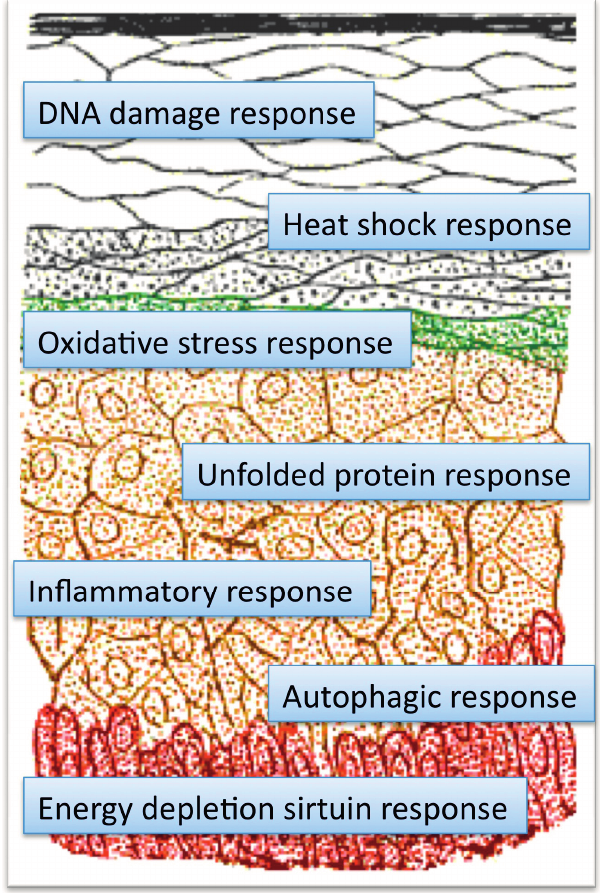
Figure 1. Major stress response pathways in the skin, which detect disruption of the homeodynamics and initiate a series of maintenance and repair processes, with eventual health beneficial